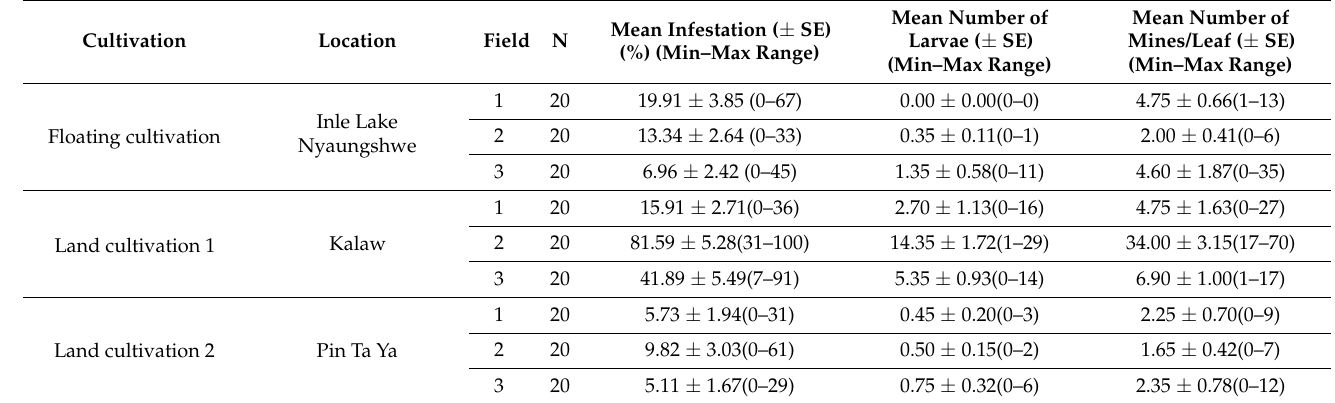
Table 2. Mean Tuta absoluta infestation level and number of mine blotches per tomato leaflet at three locations under two different cultivation